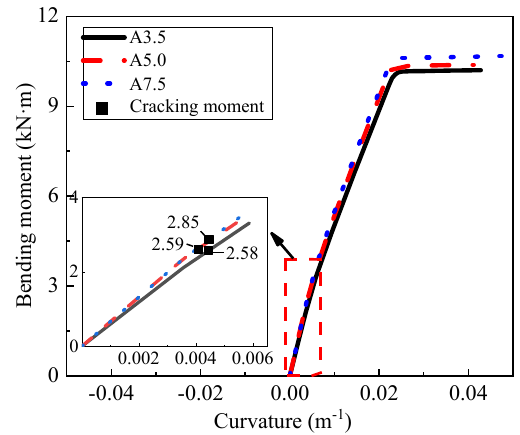
Figure 20. Effect of the strength grade.